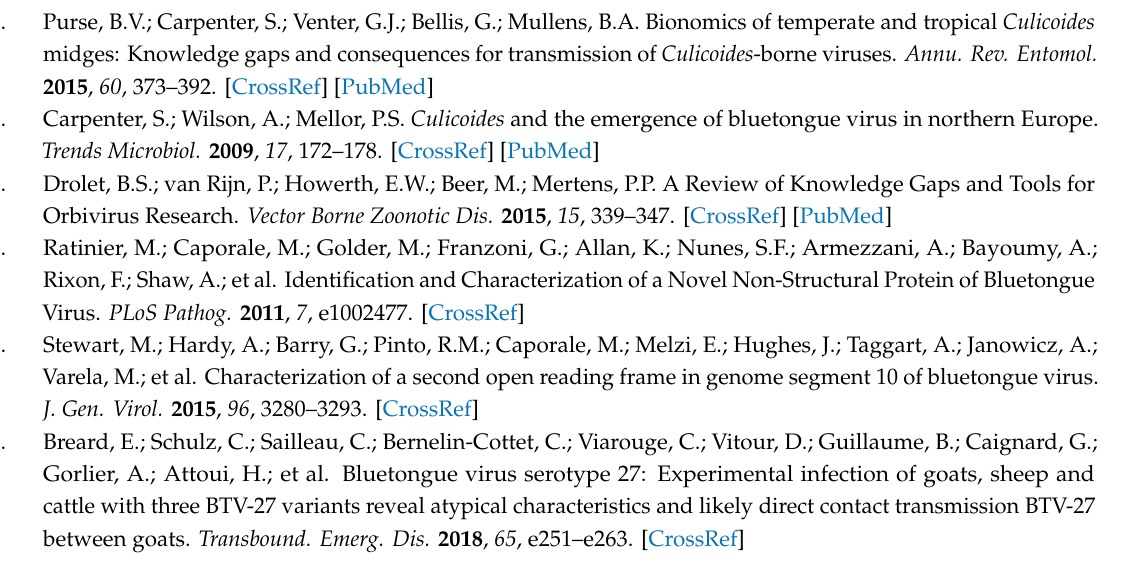
Table S1: Levels of bluetongue virus RNA (C q ) detected in intrathoracically inoculated Culicoides sonorensis following incubation for 5 days at 25 ◦ C and exposure to uninfected sheep. Table S2: Levels of bluetongue virus RNA (C q ) detected in sheep following exposure to Culicoides sonorensis intrathoracically inoculated with either a strain of BTV serotype 1 or serotype 8. Table S3: Feeding of uninfected Culicoides sonorensis on sheep infected with bluetongue virus. Culicoides sonorensis successfully taking a blood meal were processed immediately following feeding and following incubation for 8 days at 25 ◦